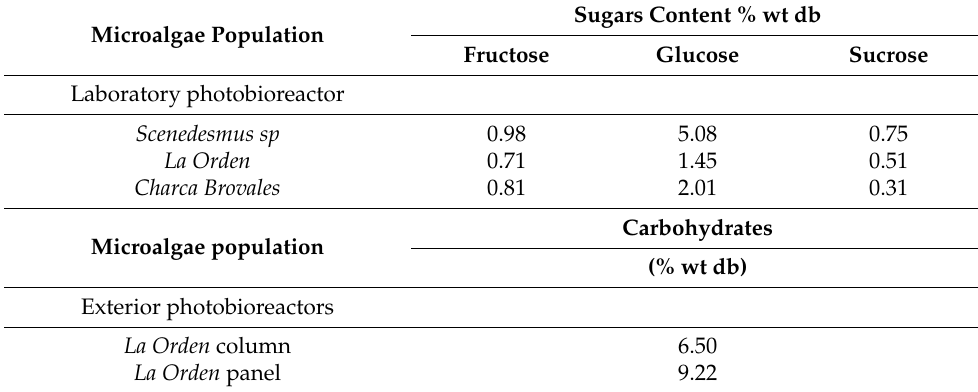
Table 5. Sugars and carbohydrates content of the microalgae populations in fertilizer